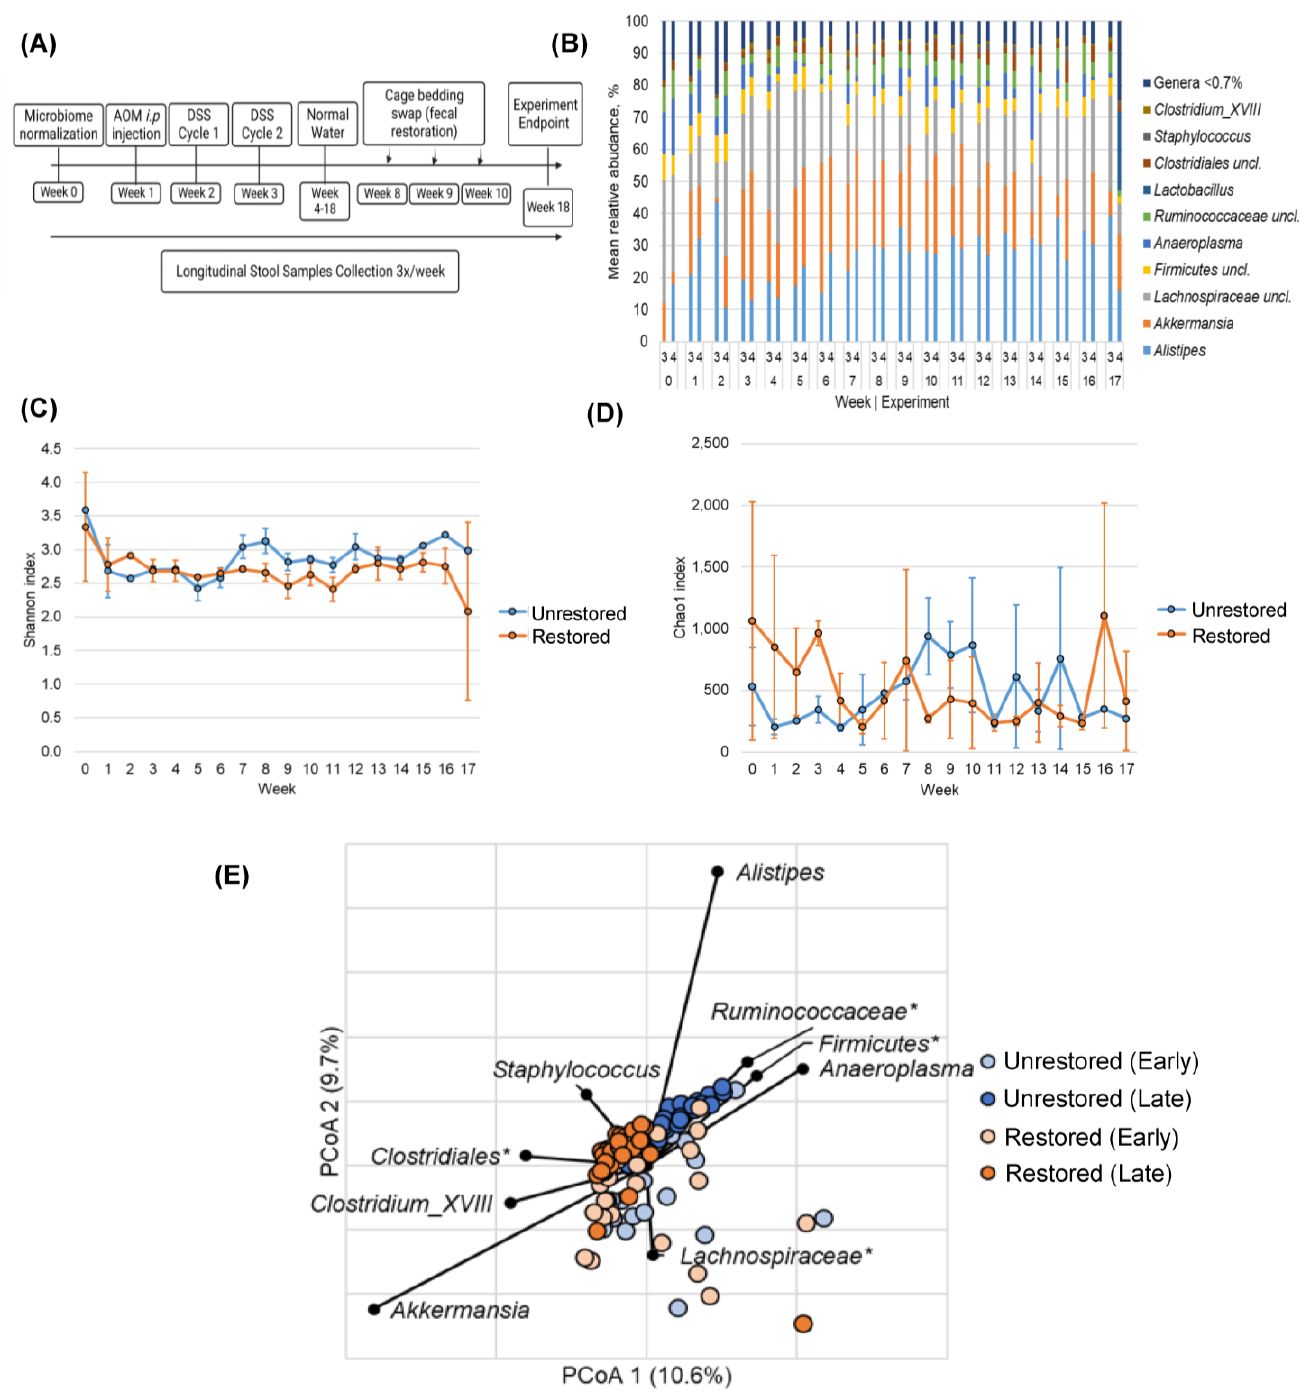
Figure 1. Microbiome composition and diversity in Balb/c mice. ( A ) Percentage of the relative abun- dance of bacterial genera in Balb/c mice following AOM/DSS administration between (3) unrestored and (4) restored groups. Genera that accounted for <0.7% of mean sequence reads were consolidated for clarity. ( B ) Longitudinal Shannon index between no restoration (blue) and restoration (orange). Error bars reflect standard deviation. ( C ) Longitudinal Chao1 index between no restoration (blue) and restoration (orange). ( D ) Principal coordinates analysis ( E ) Correlated taxa associated with ordination position on either axis (Spearman p > 0.05) are overlaid on the PCoA plot. (*) Indicates genera that could not be further